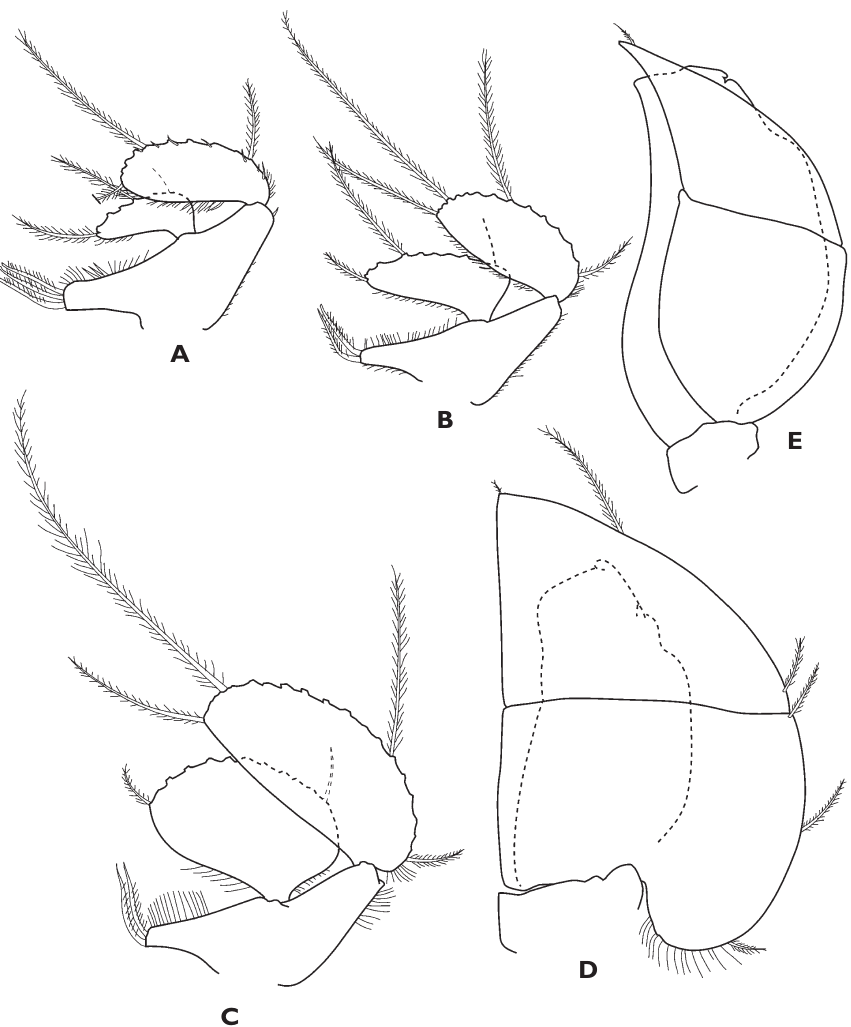
Figure 27. Th ysanoserolis orbicula sp. n. Holotype. A–E pleopods 1–5 respectively. without median tubercle. Eyes minute (less than 5% greatest width of head), reniform, ommatidia not distinct (possibly absent). Pereonites all entire, articulating; Pereonite 1 anterolateral margin continuously convex; dorsal surfaces without tubercles. Coxae of pereonites 2–4 articulated, with dorsal sutures, distal margins weakly convex; coxae 4 extending to anterior margin of pleotelson; coxae 5 extending posteriorly along 0.5 of pleotelson length; coxae 6 extending to posterior margin of pleotelson, and along 0.8 of pleotelson length. Pleonites extending posteriorly along 1.1 pleotelson lateral margin; pleonite 1 sternal plates with single median lobe, sternal plate 1 without me- dian ridge. Pleotelson 0.8 times as long as anterior width; dorsal surface with